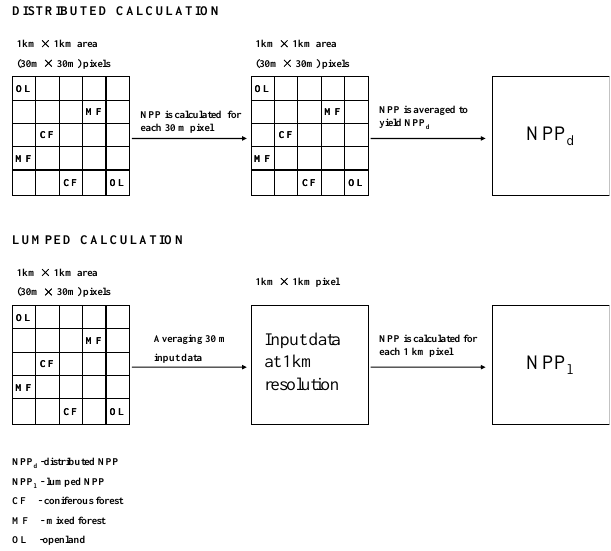
Figure 1. Procedures for distributed and lumped NPP calculations. 25 Fig. 1. Procedures for distributed and lumped NPP